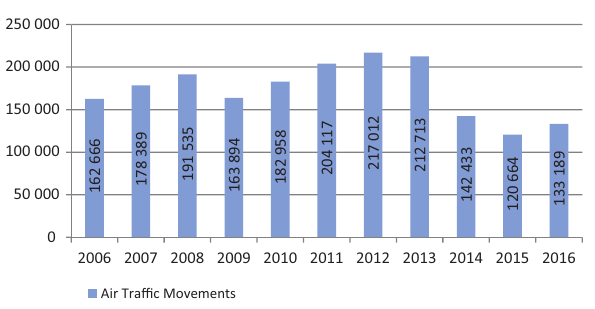
Figure 11. Air traffic movements in 2006–2016